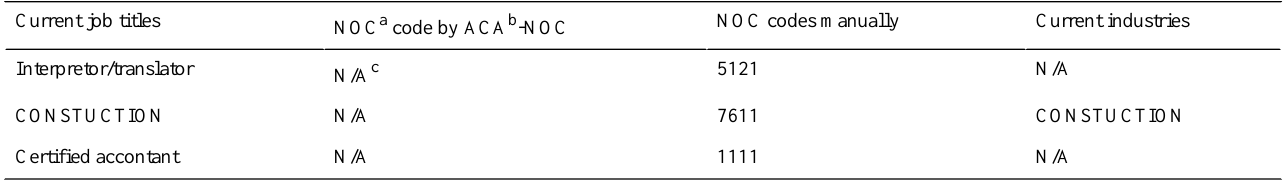
Table 4. Examples of unmatched data for Generation 0.